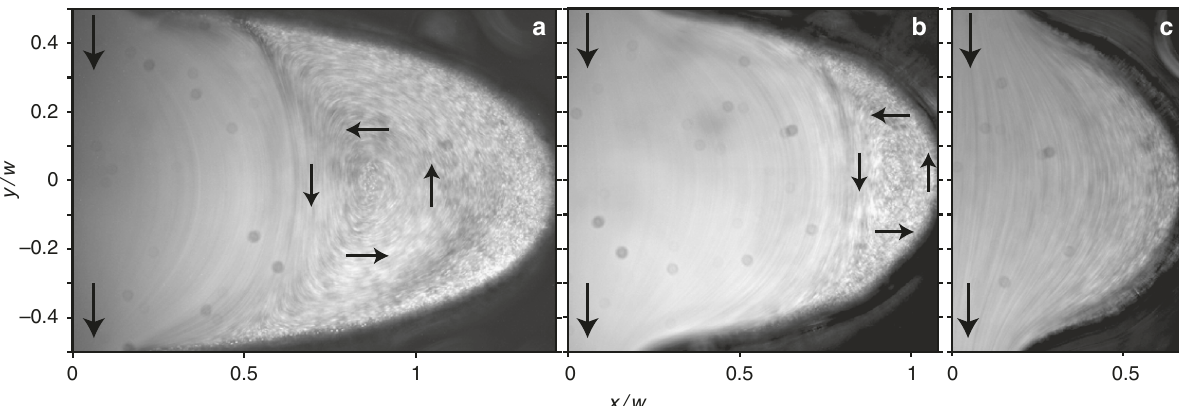
Fig. 2 Long-exposure particle streaks of the fl ow in cavities of different eccentricity values. Snapshots of the fl ow in cavities of a e = 0.95, Re = 0.08; b e = 0.9, Re = 0.07; and c e = 0.75, Re = 0.02; see also corresponding Supplementary Movies 2 – 4. Black arrows indicate the fl ow direction